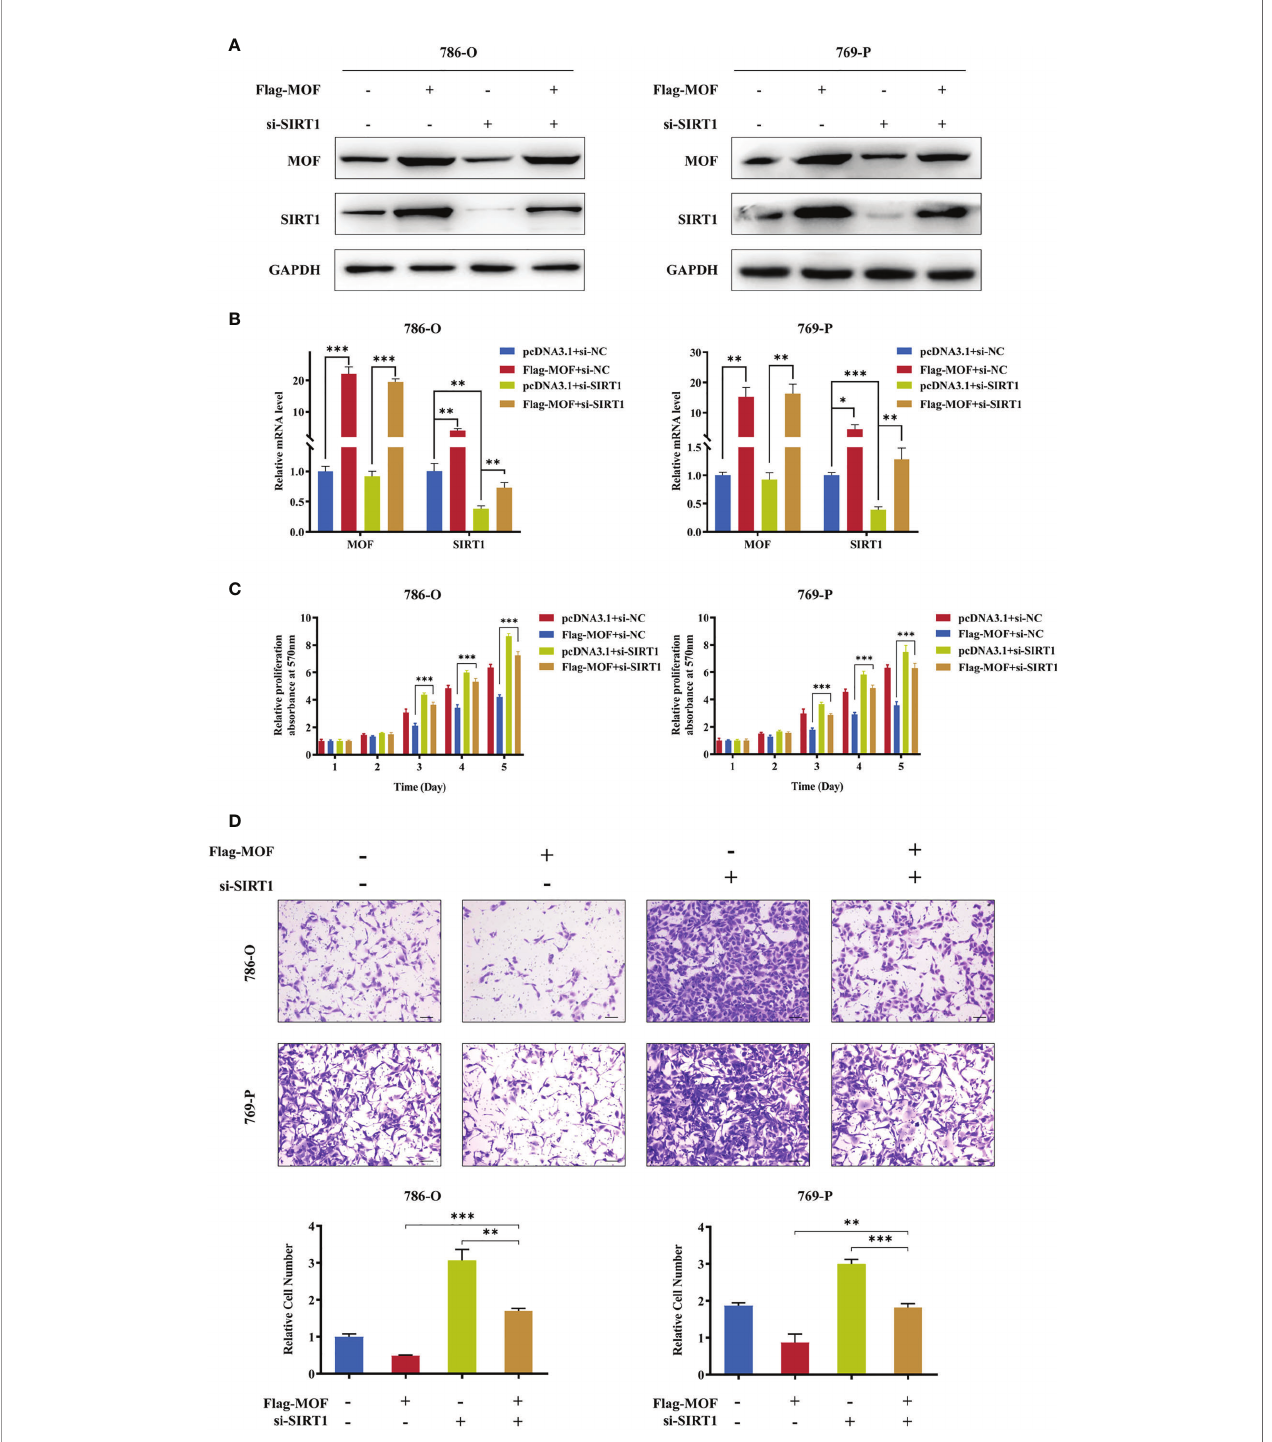
FIGURE 5 | SIRT1 knockdown restored MOF-induced inhibition of cell proliferation and migration. (A, B) Western blot (A) and qRT-PCR (B) assays demonstrated the ef fi ciency of SIRT1 knockdown and MOF overexpression in 786-O and 769-P cells. (C) SIRT1 knockdown restored the inhibited cell proliferation induced by MOF overexpression. (D) SIRT1 knockdown restored the inhibited cell migration induced by MOF overexpression. Scale bar, 100 m m. (*, p < 0.05, **, p < 0.01, ***, p <